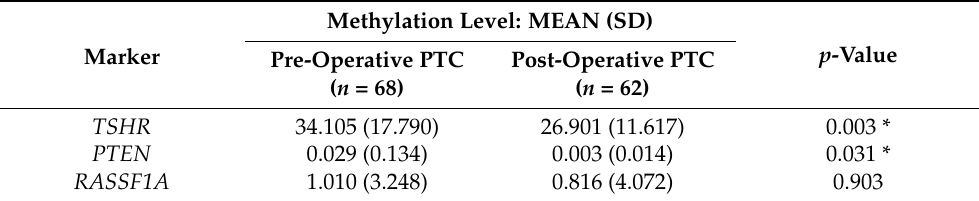
Table 2. Plasma TSHR, PTEN , and RASSF1A methylation in papillary thyroid cancer (PTC) patients before and after thyroidectomy. Analysis of Wilcoxon signed-rank test was used. * p < 0.05.